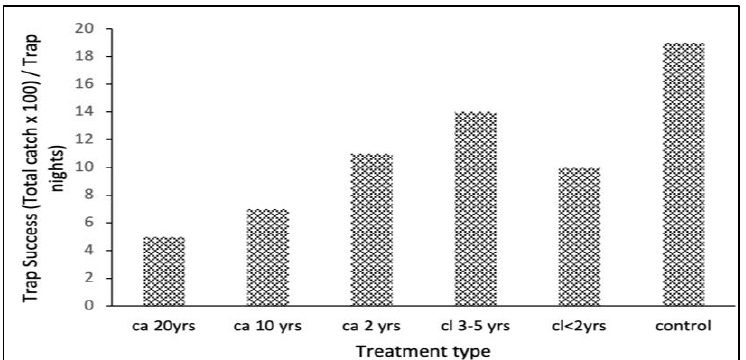
Figure 5. Trap success by treatment type inside the reserve.